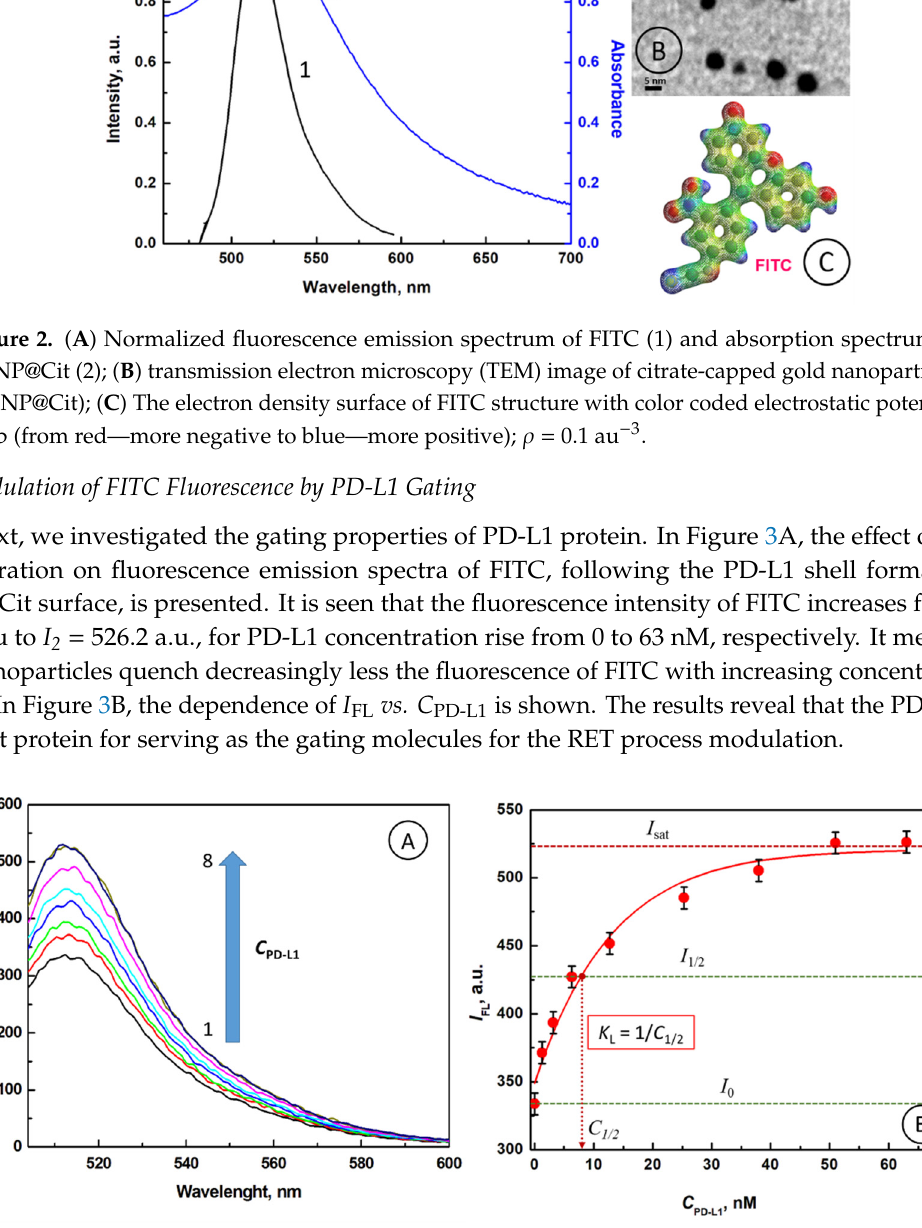
Figure 3. ( A ) Fluorescence emission spectra of AuNP@FITC for different concentrations of PD-L1, C PD-L1 [nM]: (1) 0, (2) 1.27, (3) 3.17, (4) 6.3, (5) 12.7, (6) 25.3, (7) 38, (8) 51, (9) 63.0. ( B ) The dependence of I FL vs. C PD-L1 , C FITC = 66.7 nM, C AuNP@Cit = 2.02 nM, C PD-L1 = 0 − 63 nM, λ ex = 495 nm.